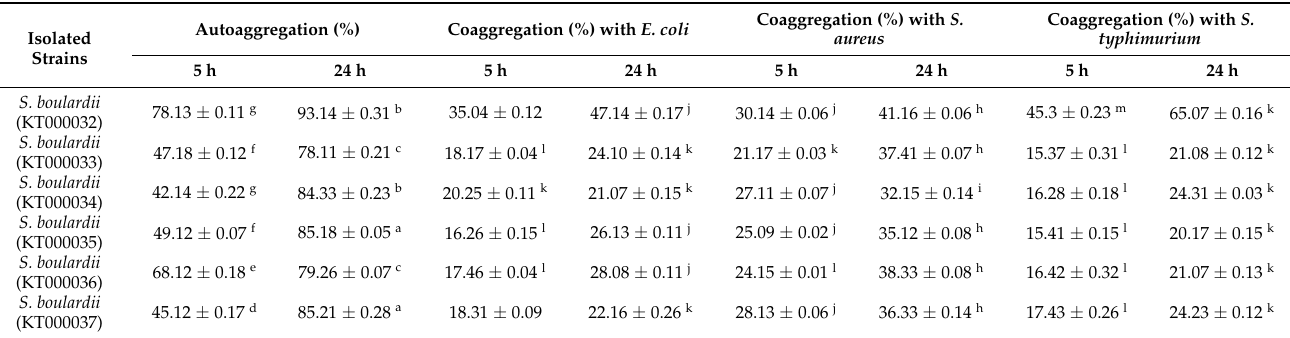
Figure 3. Antibacterial activities of S. boulardii (KT000032) cell free supernatant against the following pathogens ( a ) E. coli ( b ) S. aureus ( c ) S. typi ( d ) S.dysenteriae ( e ) V. cholerae ( f ) S. flexneri . Bars represent the means of three replicates ( n = 3) ± SD. Data points with the same alphabets are not significantly different ( p >0.05) using one-way ANOVA followed by Tukey’s test (ANOVA Software—New Version 2021.2). Table 6. Auto-aggregation and co-aggregation abilities of potential probiotic Saccharomyces boulardii strains after 20 h incubation at 37 ◦